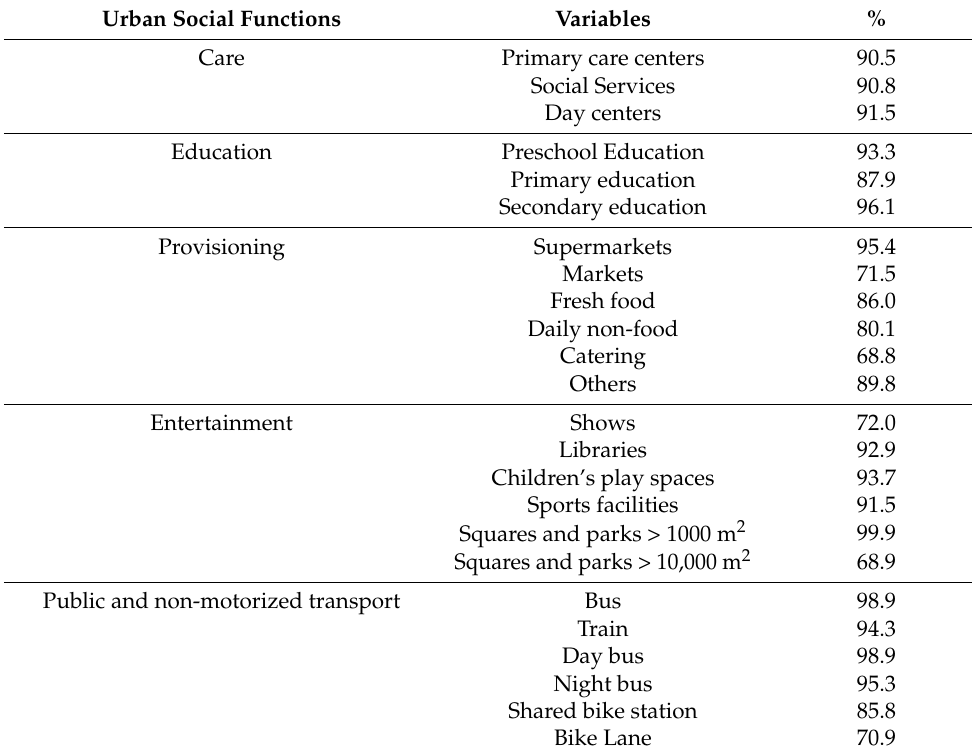
Table 2. Share of cadastral parcels with FMC access to selected